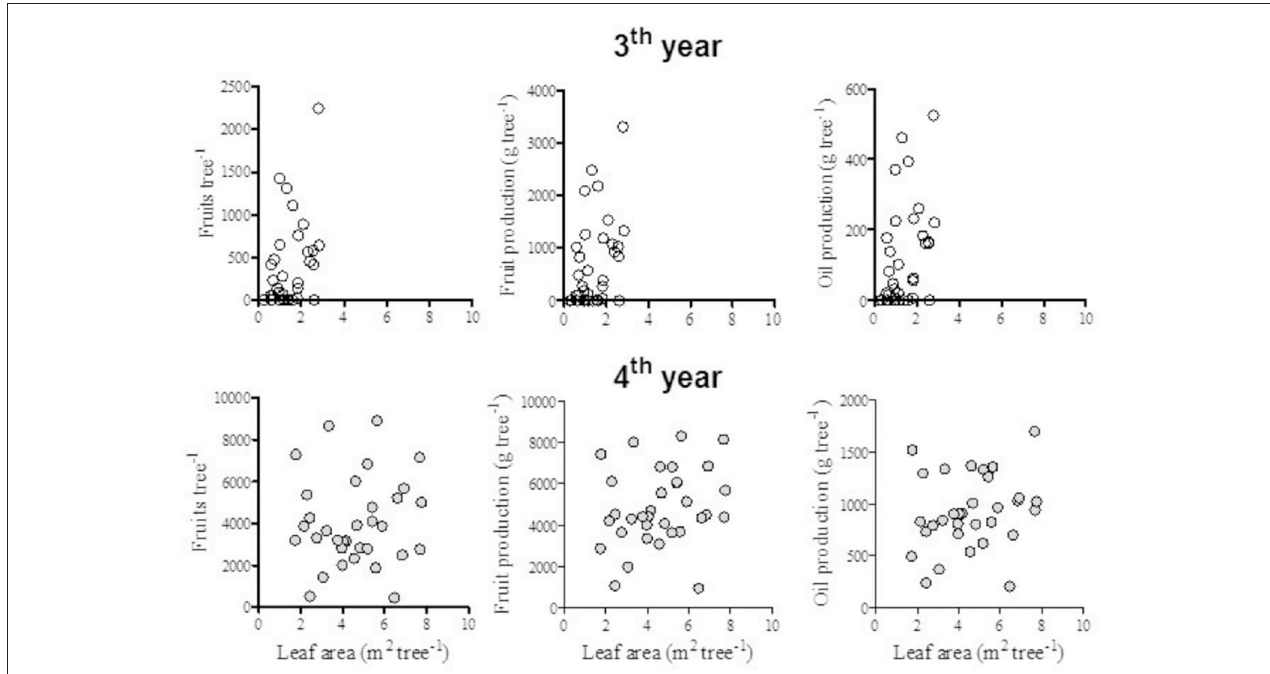
FIGURE 5 | Relationships between fruit number and leaf area during the 3rd and 4th years of production in the experimental trees at various intra-row spacing. Points correspond to individual trees.